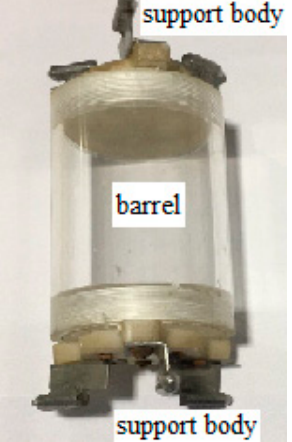
Figure 2. Physical diagram of the capsule. Table 1. Basic coordinates of the mathematical model (unit: m).